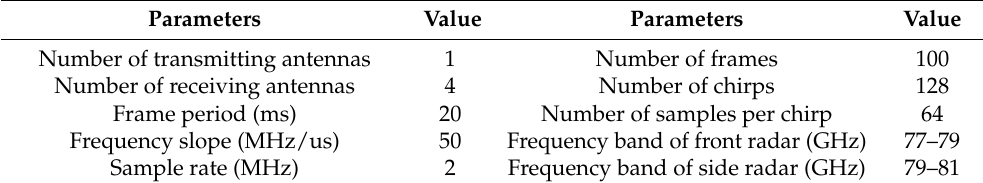
Table 1. Radar parameters configuration.